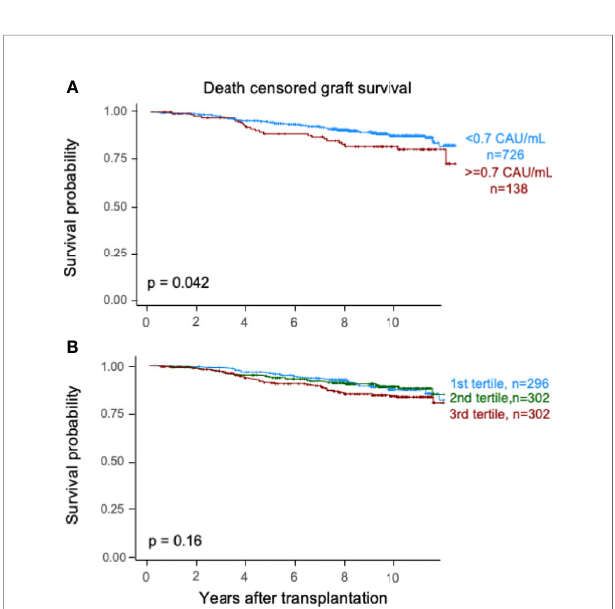
FIGURE 4 | Kaplan – Meier estimates of death-censored graft survival after kidney transplantation according to plasma terminal C5b-9 complement complex (TCC) concentration 10 weeks after transplantation; (A) cut point of <0.7 CAU/ml and (B)